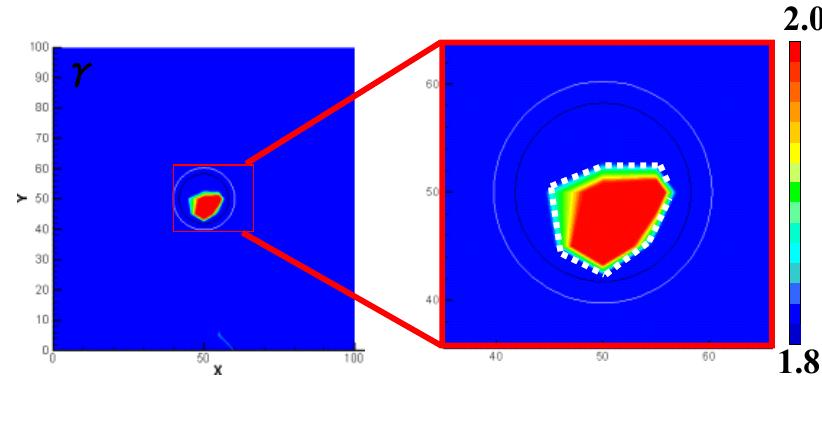
Figure 11. Damage image using absolute value of sensor signals in a CFRP plate with